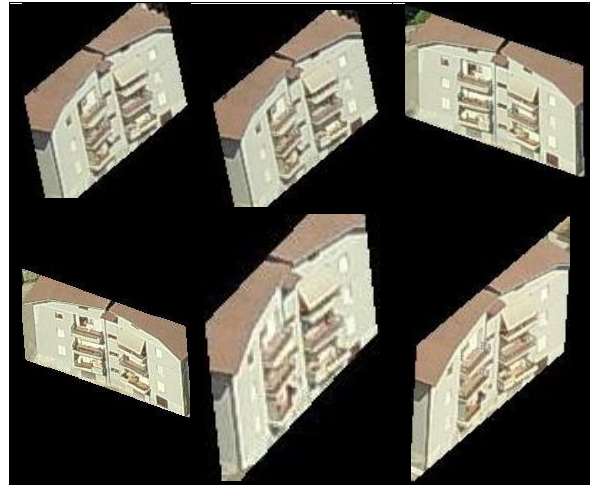
Figure 5. Examples of the same façade and same epoch, from different